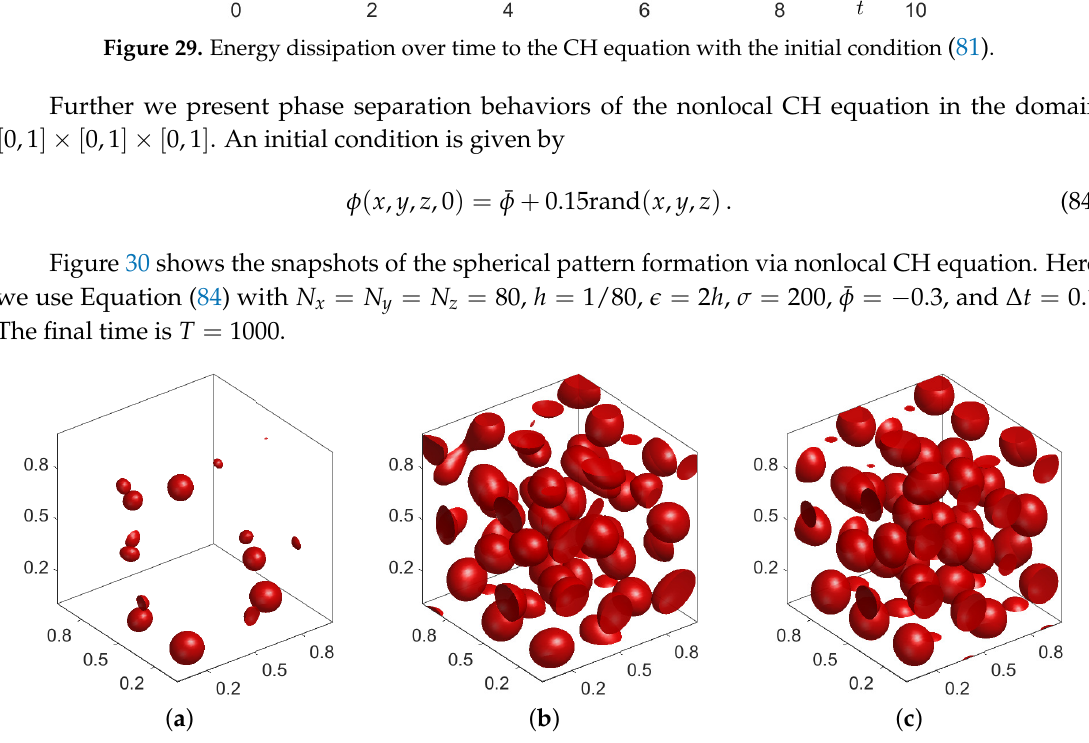
Figure 30. ( a – c ) are the snapshots of the spherical pattern formation via nonlocal CH equation at t = 400 ∆ t , 500 ∆ t , and 10,000 ∆ t ,